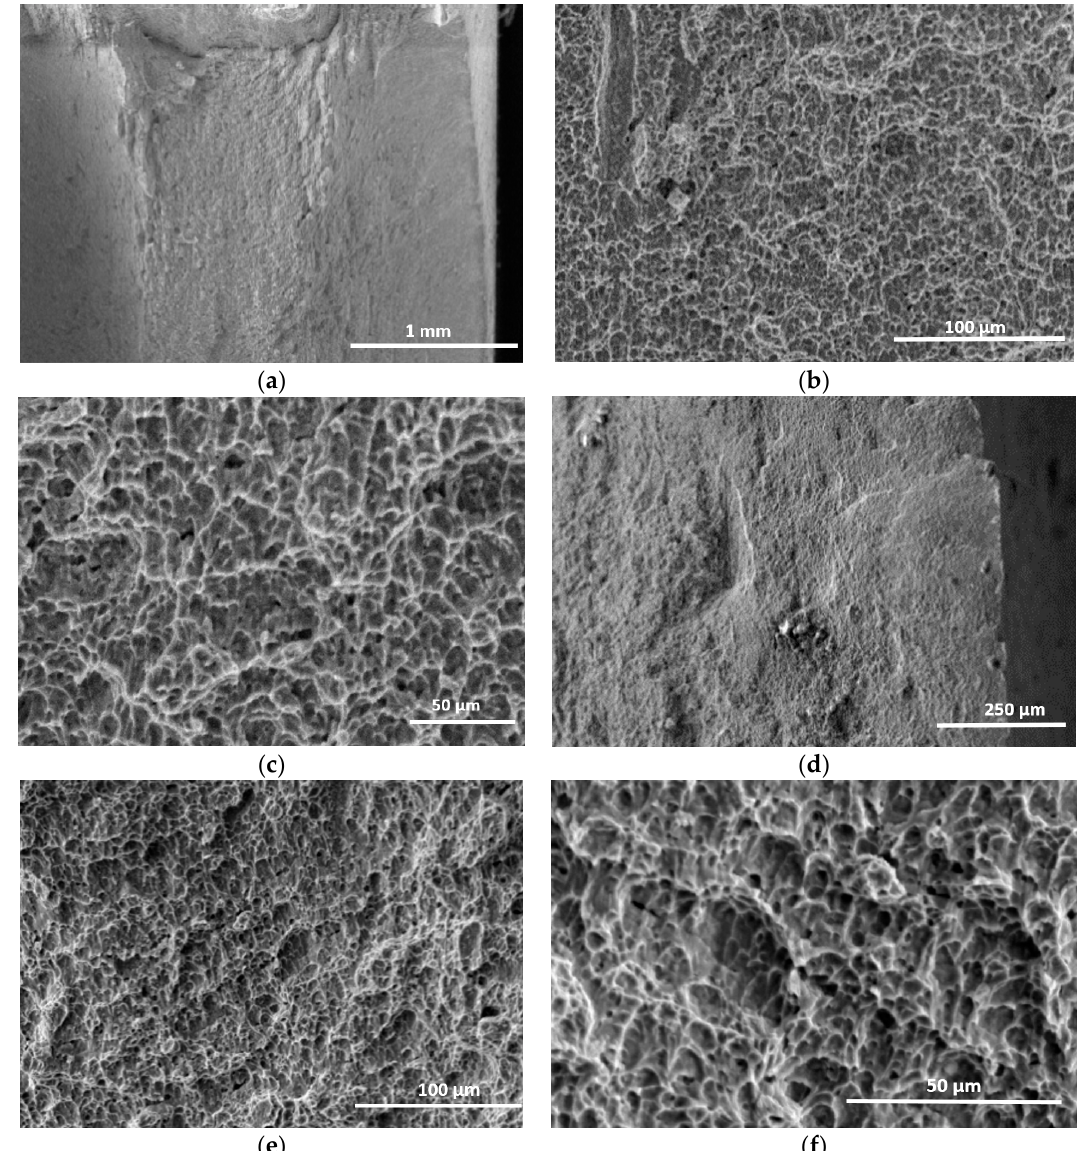
Figure 12. Fractograms of fractures of specimens from the VT23M alloy subjected to impact toughness tests under schemes 33y ( a – c ) and 48y, ε imp = 0.6% ( d – f ).